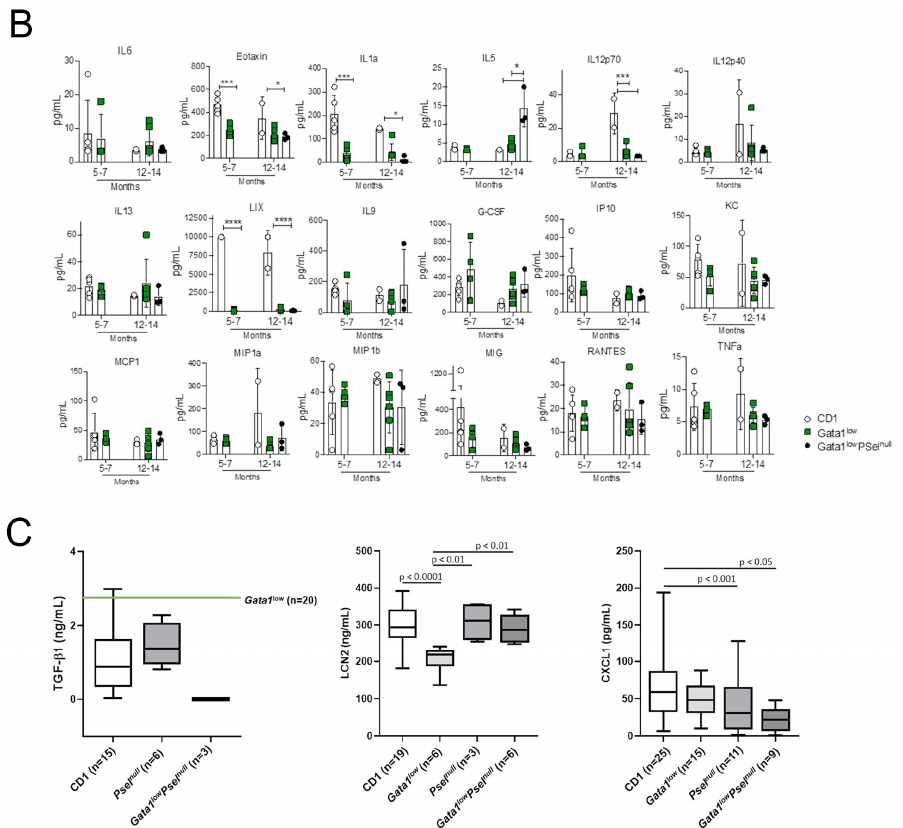
Figure 1. Modest changes in inflammatory cytokine profiling of sera from Gata1 low mice with age and with respect to CD1 littermates wild-type at the Gata1 locus and to Gata1 low Psel null mice. ( A ) Heatmap of detectable cytokines. ( B ) Concentration values for each cytokine detected. P values were calculated with multiple comparison t -tests for each cytokine. * p < 0.05, *** p < 0.01, **** p < 0.0001. ( C ) Serum levels determined by ELISA of TGF- β 1 (left), CXCL1 (middle), and LCN2 (right) in CD1 mice wild-type at the Gata1 locus, in Gata1 low mice, and in mice lacking the Psel gene with and without the Gata1 low mutation. The number of mice analyzed in each experimental group is indicated by n . Statistical analyses were performed with multiple comparison test. Since age and sex analyzed as independent variables did not reveal statistically significant differences in most of the groups (see Figure S3 and Table S1, Supplementary Materials), results obtained at different ages in females and males were pooled. The number of mice analyzed in each group was TGF- β 1: adult CD1 males n = 5; adult CD1 females n = 3, old CD1 males n = 4; old CD1 females = 3, total CD1 n = 15; adult Psel null males: n = 3; adult Psel null females n = 3, total Psel null n = 6; old Gata1 low Psel null females n = 3, total Gata1 low Psel null = 3; LCN2: adult CD1 males n = 5; adult CD1 females = 4, old CD1 males n = 5; old CD1 females n = 5, total CD1 n = 19; old Gata1 low males n = 3, old Gata1 low females n = 3, total Gata1 low n = 6; old Psel null females n = 3, total Psel null n = 3; old Gata1 low Psel null males n = 3, old Gata1 low Psel null females n = 3, total Gata1 low Psel null n = 6; CXCL1: adult CD1 males n = 8; adult CD1 females n = 6, old CD1 males n = 6; old CD1 females = 5, total CD1 n = 25; adult Gata1 low males n = 3, adult Gata1 low females n = 3, old Gata1 low males n = 4, old Gata1 low females n = 5, total Gata1 low n = 15; adult Psel null males: n = 5; adult Psel null females n = 3, old Psel null females n = 3, total Psel null n = 11; adult Gata1 low Psel null males n = 3, old Gata1 low Psel null males n = 3, old Gata1 low Psel null females n = 3, total Gata1 low Psel null n = 9. Abbreviations: TGF- β 1, transforming growth factor β 1; LCN2, lipocalin-2; Psel, P-selectin; IL6, IL1a, IL5, IL12p70, IL12p40, IL13, and IL9, interleukin 6, 1a, 5, 12p70 and p40, 13 and 9, respectively; LIX, also known as CXCL5 (C-X-C motif chemokine 5); G-CSF, granulocyte-colony stimulating factor; KC, also known as CXCL1 (C-X-C motif chemokine 1); MCP1, monocyte chemoattractant 1; MIP1a and MIP1b, macrophage inflammatory protein a and b; MIG, also known as CXCL9; TNFa, tumor necrosis factors